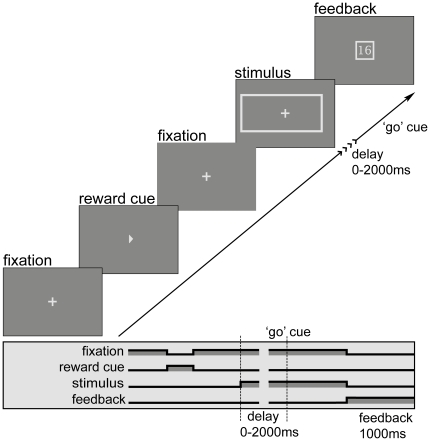
Procedure of the perceptual decision-making task with unequal payoffs.The reward cue (a left or right pointing triangle) indicates which choice, if correct, receives higher reward. Timing of the stages of the experiment is depicted on the bottom. The “Go” cue comes on with a delay of , ,  or  milliseconds. See text for details.